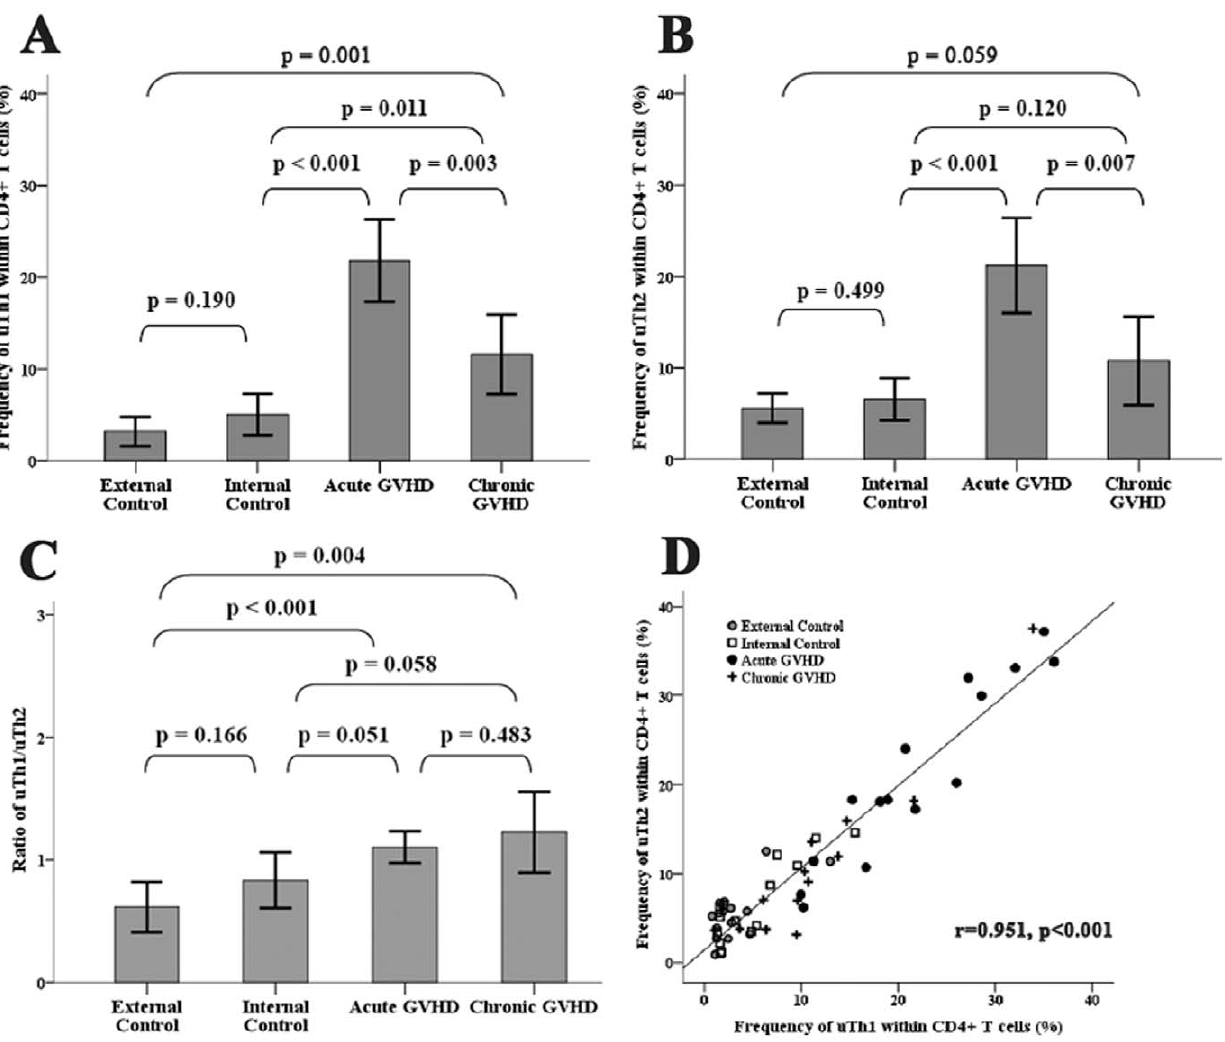
Figure 6. Correlation between uTh1, uTh2, and GVHD. The frequencies of uTh1 and uTh2 are significantly higher when patients had GVHD (figure 6A/6B, student t -test). The ratio of uTh1/uTh2 is significant lower in ‘‘No GVHD-external control’’ and tends to be lower in ‘‘No GVHD-internal control’’ when comparing to that of acute and chronic GVHD (figure 6C, student t -test). Pearson correlation test shows perfect positive correlation between the frequency of uTh1 and uTh2 (figure 6D). Bar represents mean and error bar represents 2X standard error of the mean. (figure